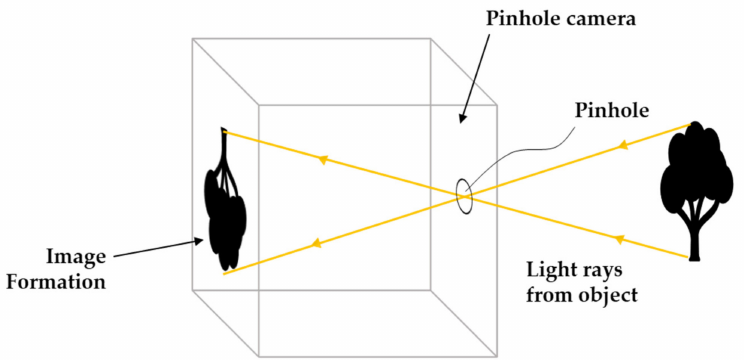
Figure 6. A graphical representation of the pinhole camera. The pinhole (aperture) restraints the light rays from the target from entering the pinhole; hence, affecting the brightness of the captured image (during image formation). A large pinhole (a wide opening) will result in a brighter image but is less clear due to blurriness on both background and foreground. Figure redrawn based on depictions in